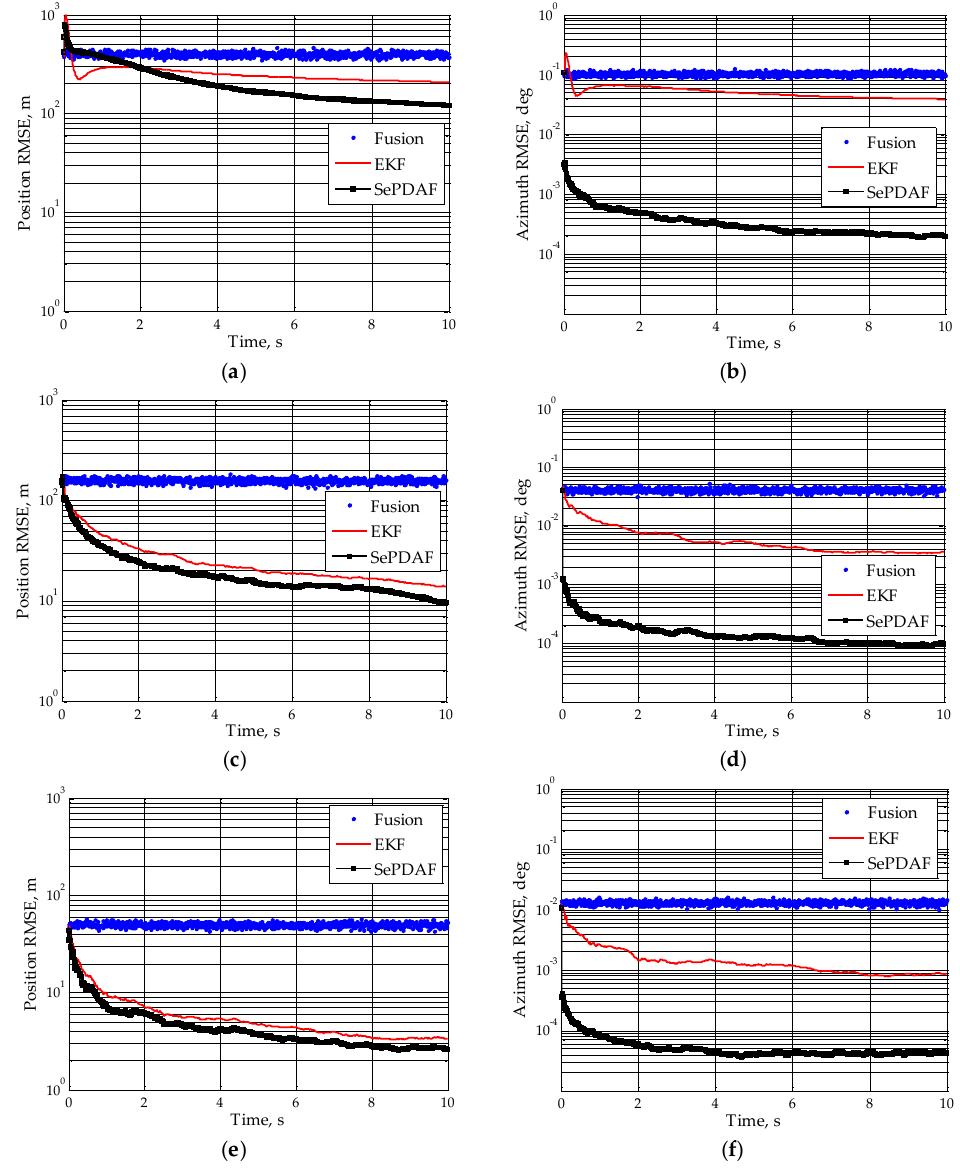
Figure 2. Position RMSE and azimuth RMSE after using the proposed method: ( a , b ) SNR = 12 dB; ( c , d ) SNR = 20 dB; and ( e , f ) SNR = 30 dB.